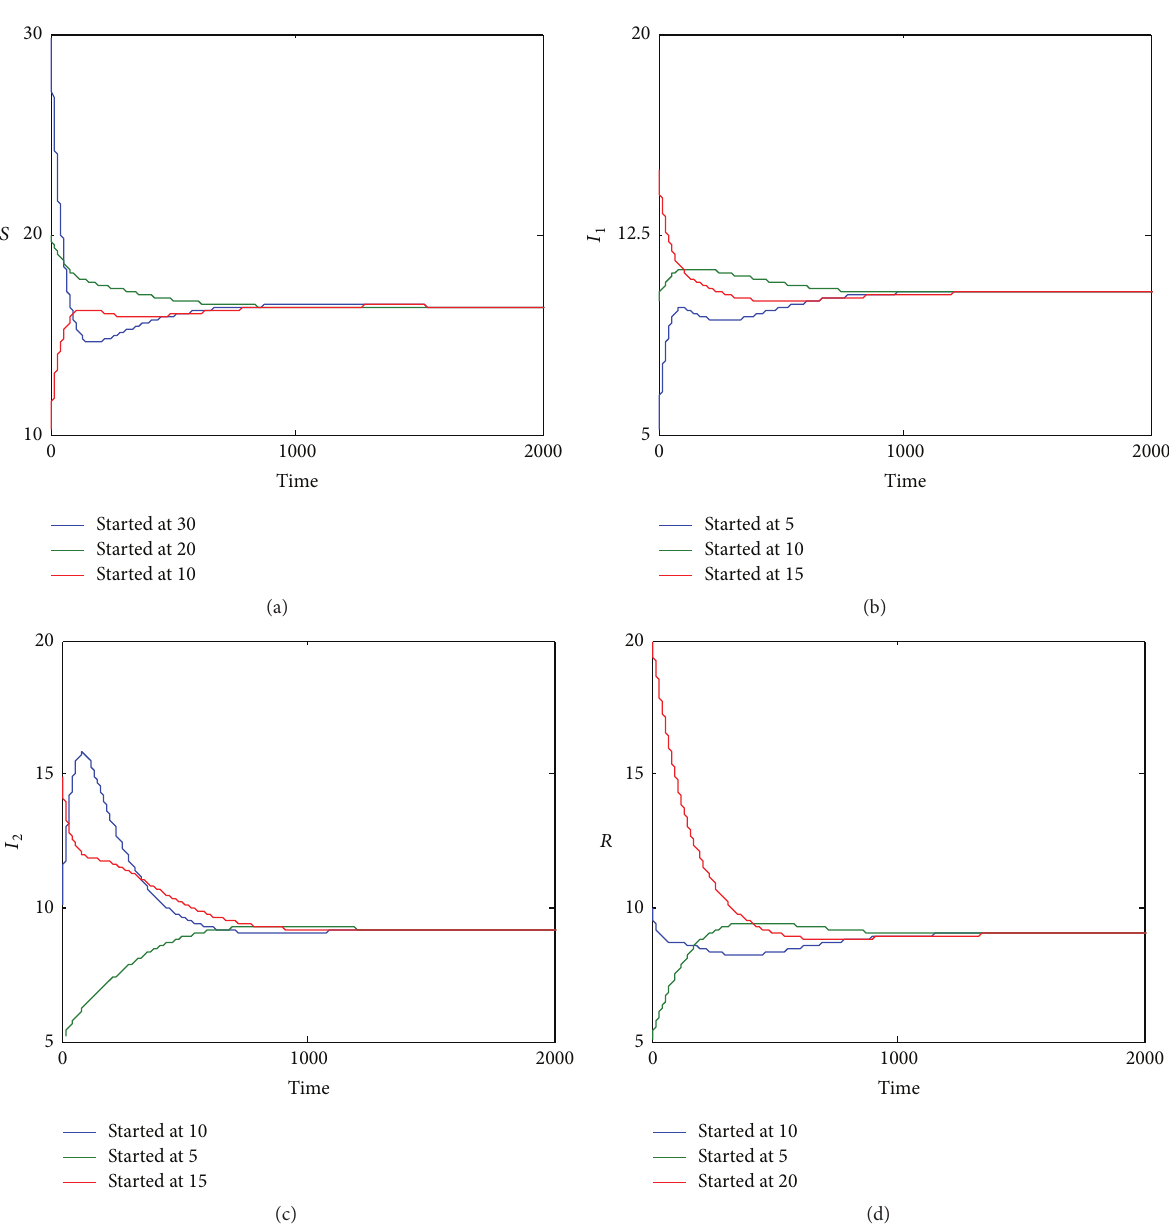
Figure 1: Globally asymptotically stable positive equilibrium point of model (1) for the parameters set (81), started from different sets of initial